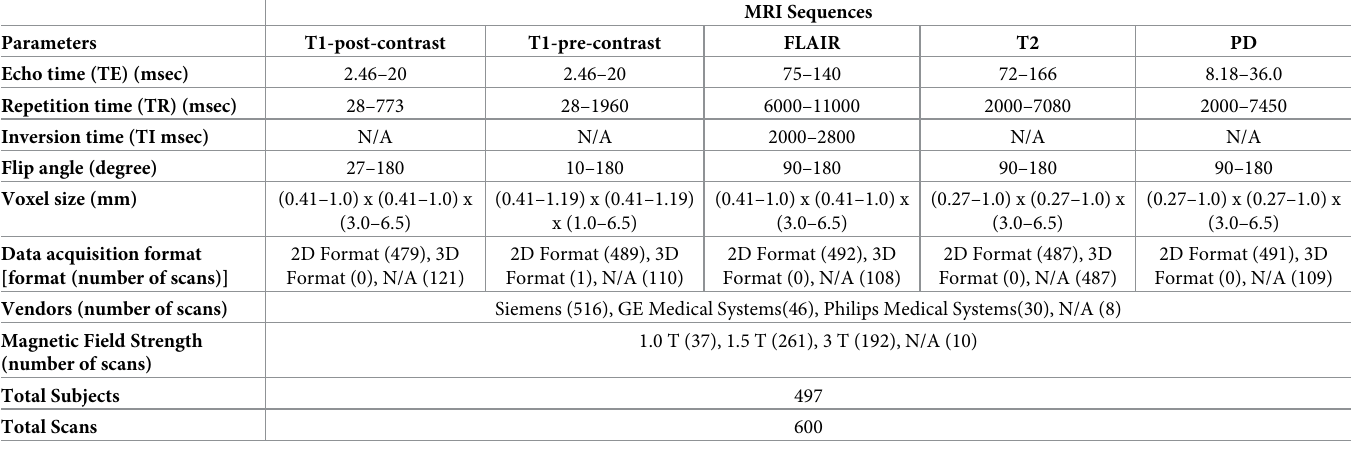
Table 1. Summary of MRI sequence parameters for manual segmentation dataset (Dataset